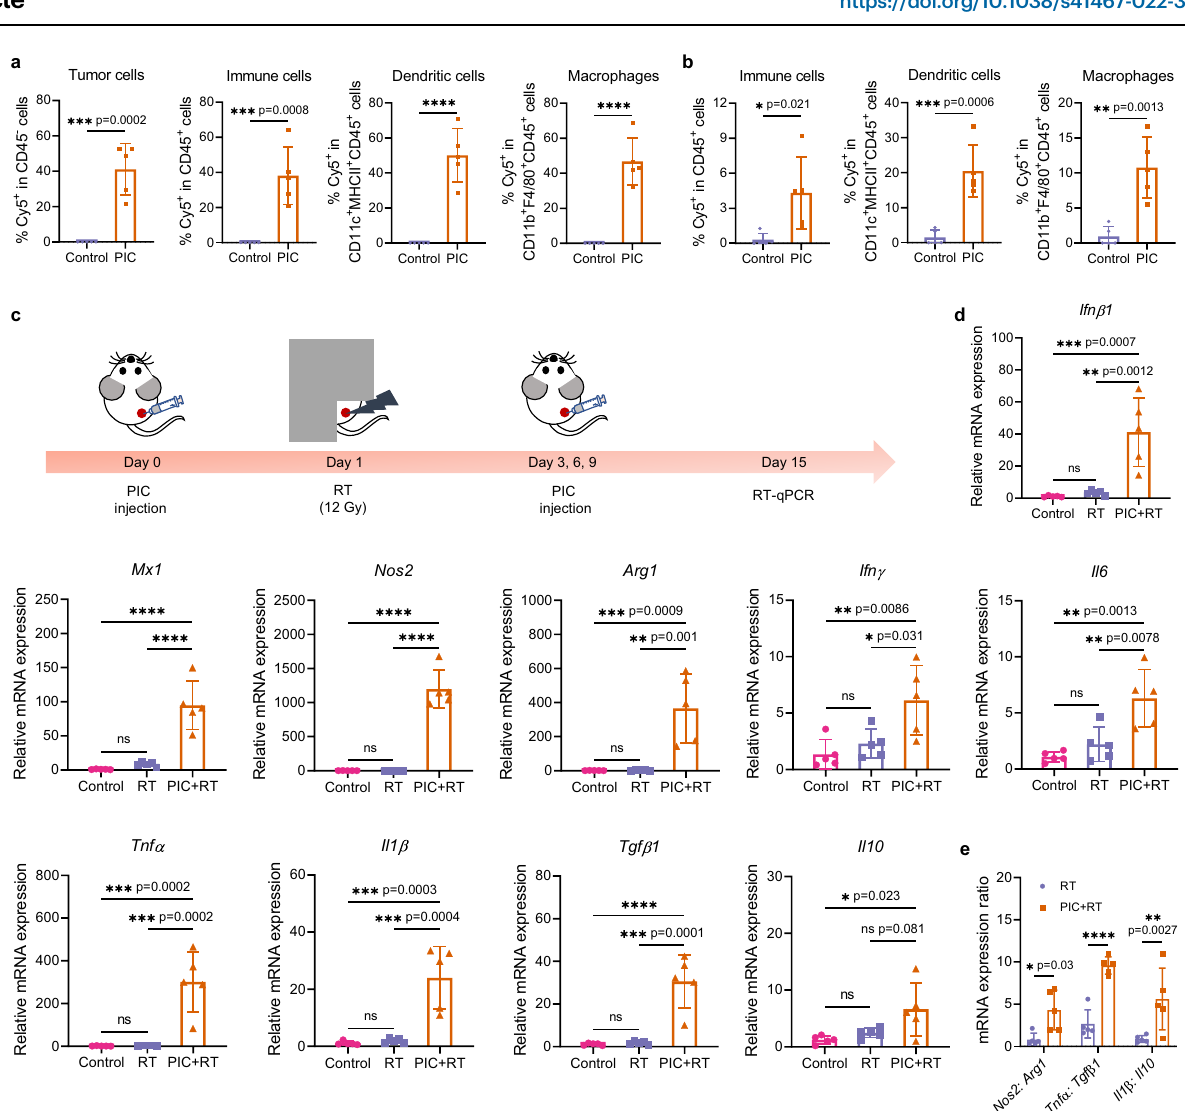
Nos2 , Arg1 , Ifn γ , Il6 , Tnf α , Il1 β , Il10 and Tgf β 1 )inB78tumorsatday15afterinitiation of indicated treatments. e The mRNA expression ratios of Nos2 : Arg1 , Tnf α : Tgf β 1 and Il1 β : Il10 in tumors at day 15 after indicated treatments. PIC: 140 μ g/100 μ L/ dose; RT: 12Gy. ( n =5 biologically independent samples). Data in a , b and d , e are shown as mean±SD. Statistical signi fi cance was calculated via unpaired t -test in a , b , and one-way ANOVA test in d , e . * p <0.05, ** p <0.01, *** p <0.001 and **** p <0.0001. Source data are provided in Source Data fi